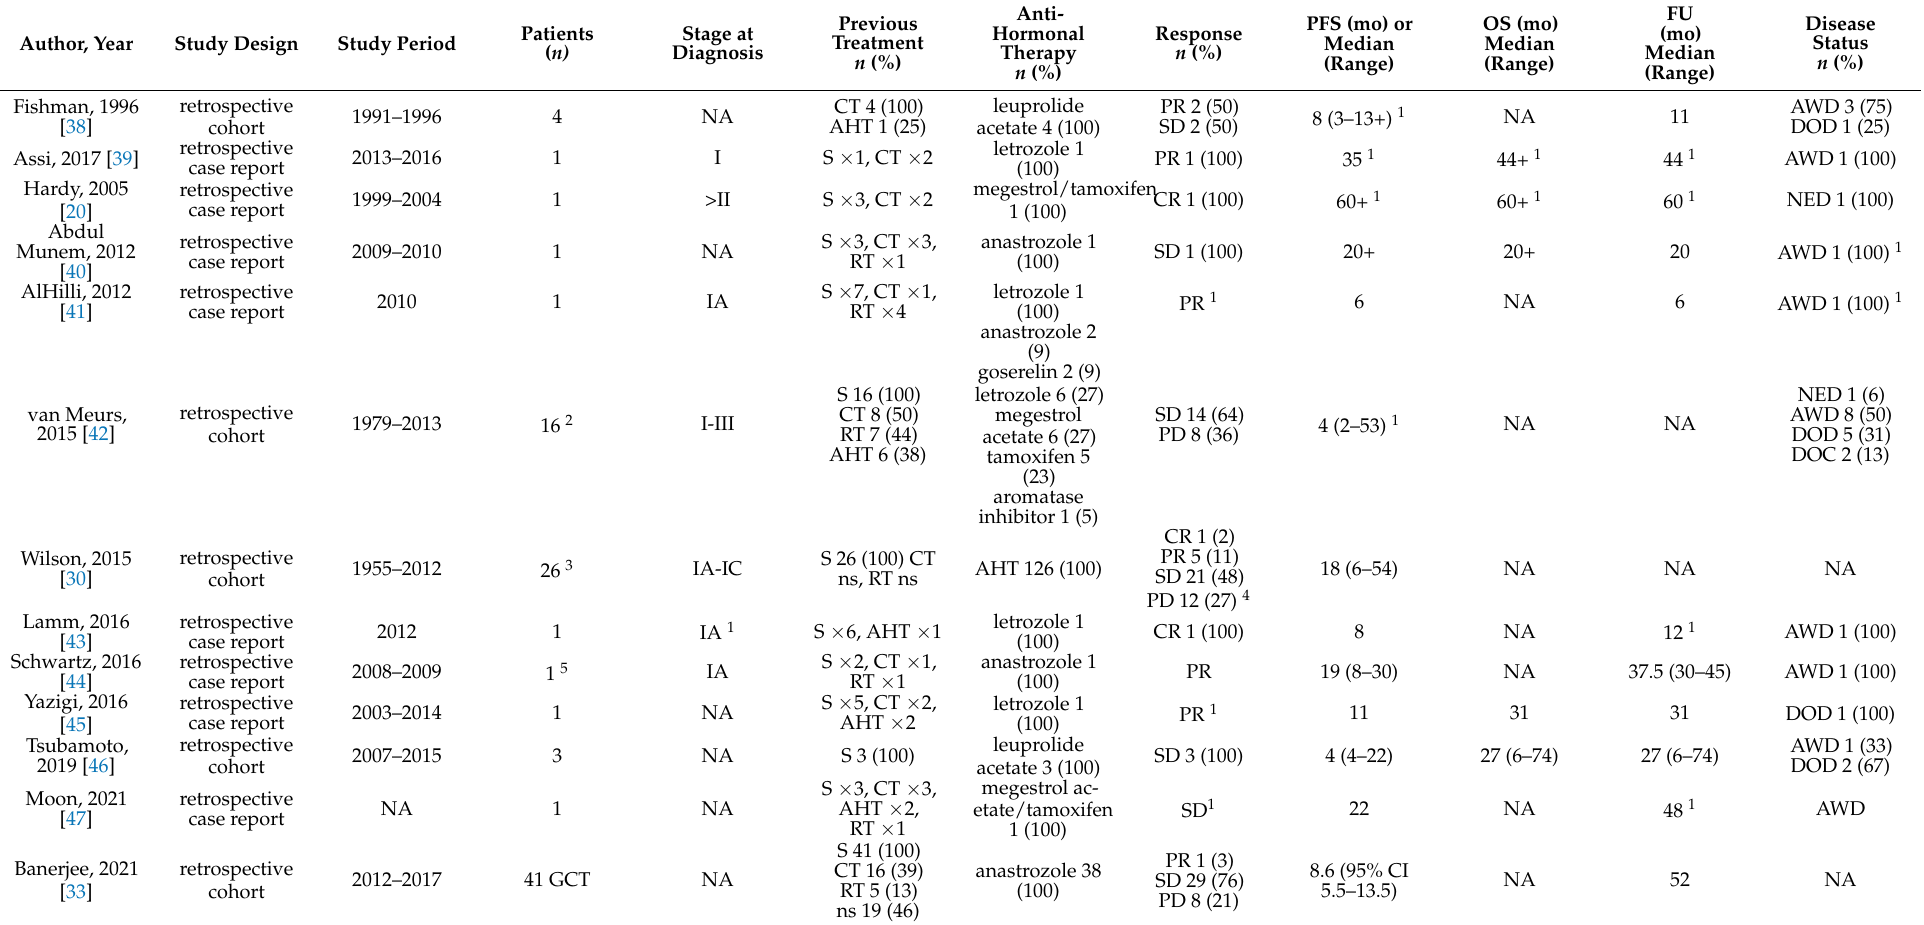
Table 2. Summary of studies describing the use of anti-hormonal therapy in